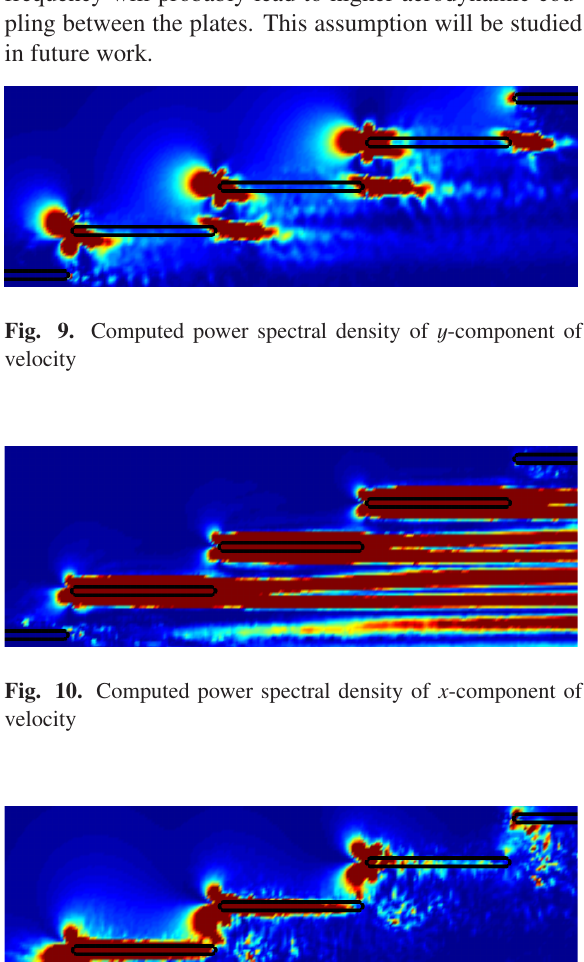
Fig. 7. Comparison of x component of velocity at point 1